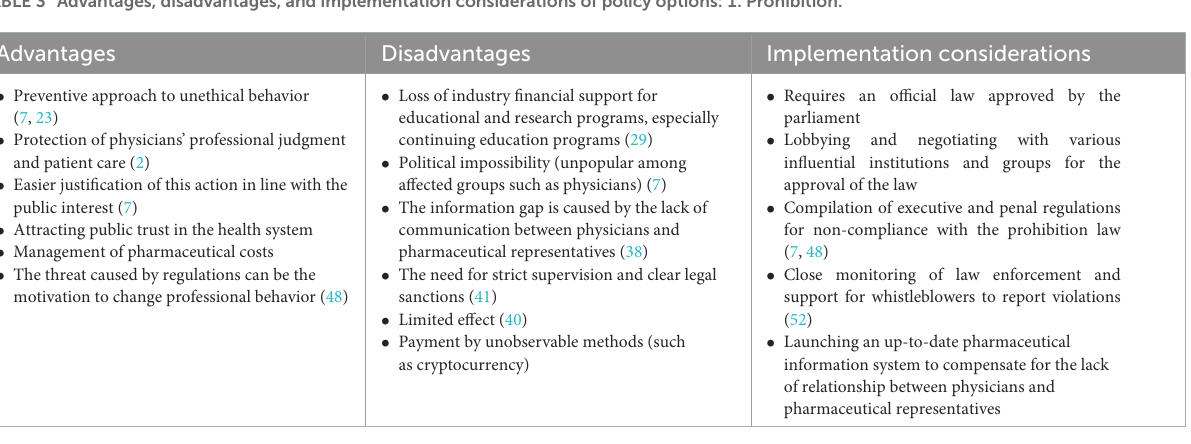
TABLE 4 Advantages, disadvantages, and implementation considerations of policy options: 2.